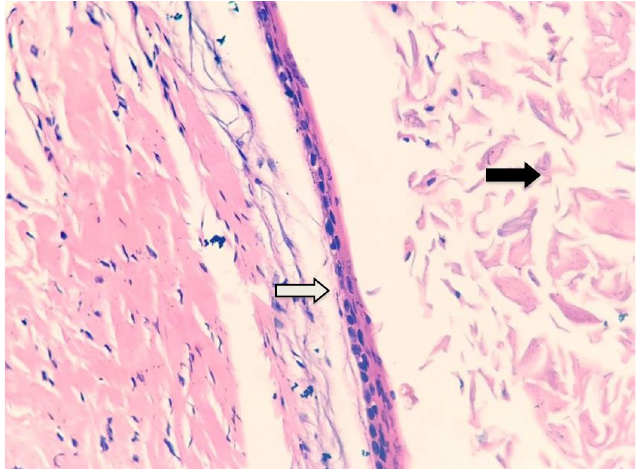
Figura 7. Fotomicrografia de cisto epidermóide em laringe. Lesão cística revestida por epitélio escamoso (seta